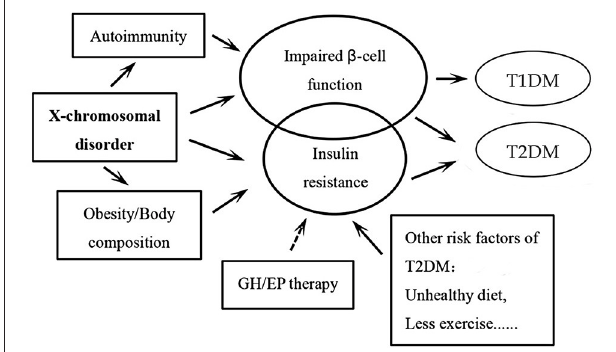
FIGURE 1 | Schematic illustration of the pathogenetic mechanisms of the developmen t of diabetes mellitus (DM) in patients with Turner syndrome. The circle of impaired β -cell function is bigger than the one of insulin resistance, as we believe that insulin secretory response to glucose is a facet of TS that likely underlies the elevated risk of DM in these patients. It is the same for the circles of type 1 DM and type 2 DM. Among all the pathogenetic factors, X-chromosomal disorder may play the most important role. The arrows “ → ” indicate that more evidence may still be needed in this respect. GH: growth hormone; EP: Estradiol and progesterone; T1DM, type 1 diabetes mellitus; T2DM, type 2 diabetes mellitus.